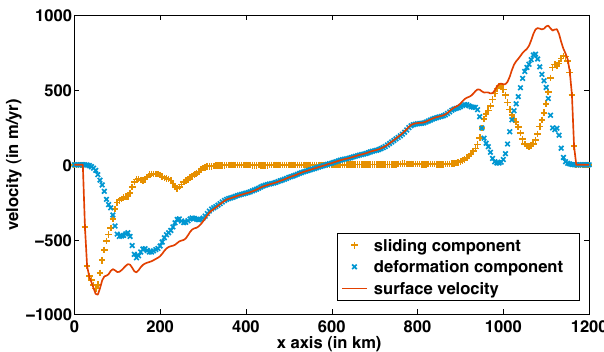
Fig. 4. Ice velocity at the surface of the ice sheet for the reference state, in metres per year, as a function of the ice sheet extent x . The total surface velocity U s is represented in red, its sliding component U slid is in orange crosses, its deformation component U s , def with cyan x (we recall that U s = U slid + U s , def